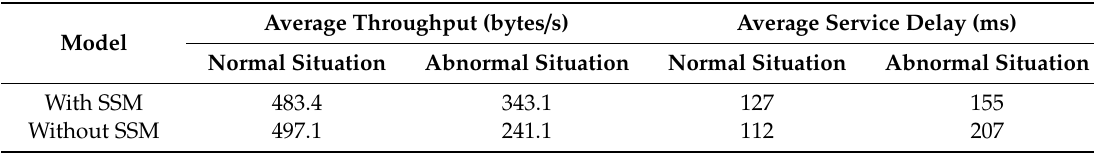
Table 3. Performance comparison between the two